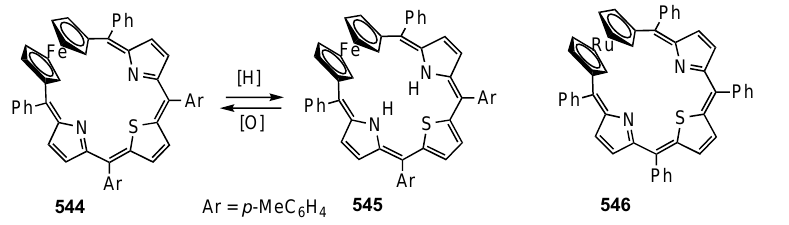
Figure 15. Metallocenoporphyrins. Figure 15.